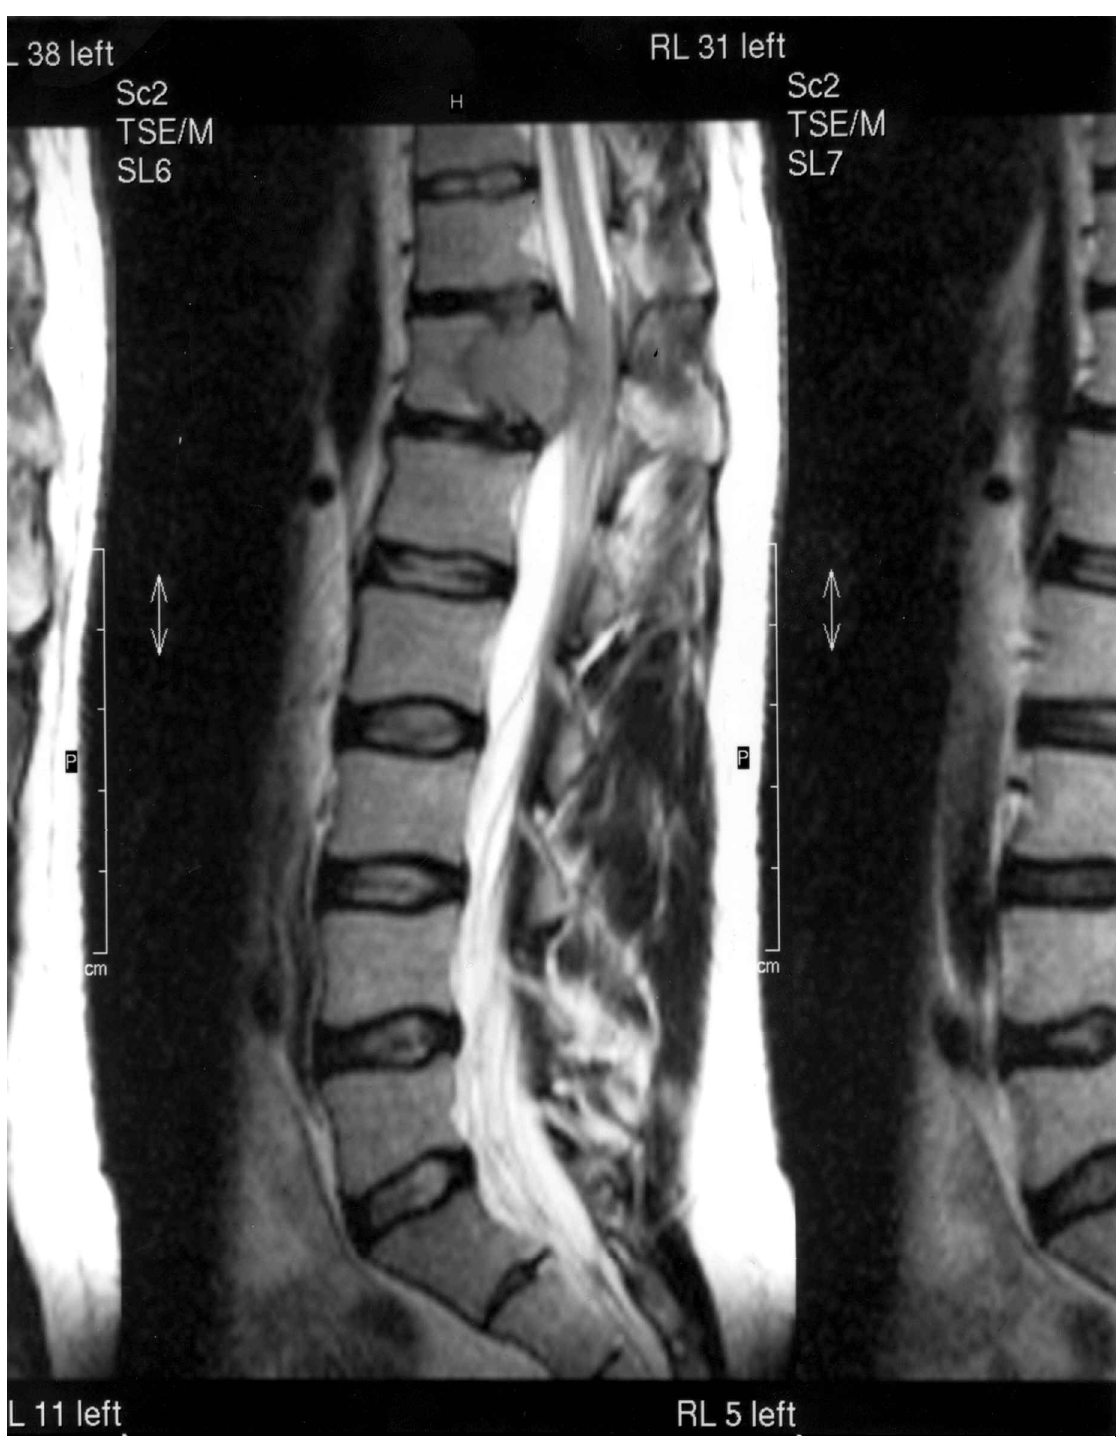
Fig. 3. Saggittal T2W showing an extradural mass arising from the posterior aspect of the twelfth thoracic vertebra compressing the thecal sac